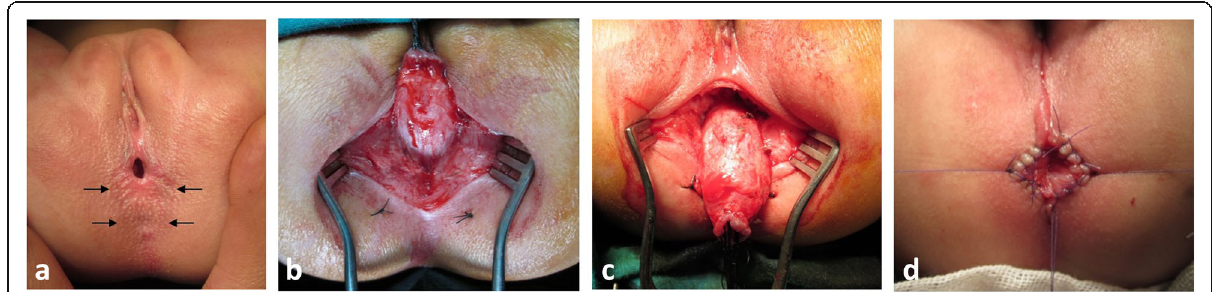
Fig. 1 Thirteen-month-old female with recto-perineal fistula underwent limited sagittal anorectoplasty. a In the supine position, we can see the anus anteriorly displaced (black arrows are pointing to the normal predestined site of the anus). b Dissection of the anorectum starts on the posterior and lateral aspects. c Separation of the anorectum from the intimately adherent vagina on the anterior aspect. d Anoplasty performed after repositioning of the anorectum backwards at the predestined site of the anus